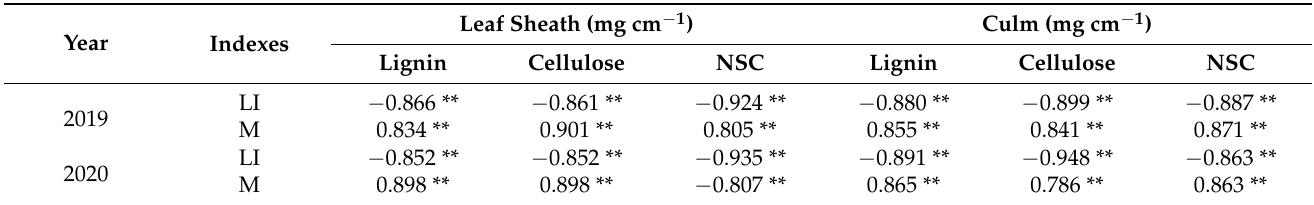
Table 10. Correlation coefficients between LI and the S2 basal internode of chemical composition